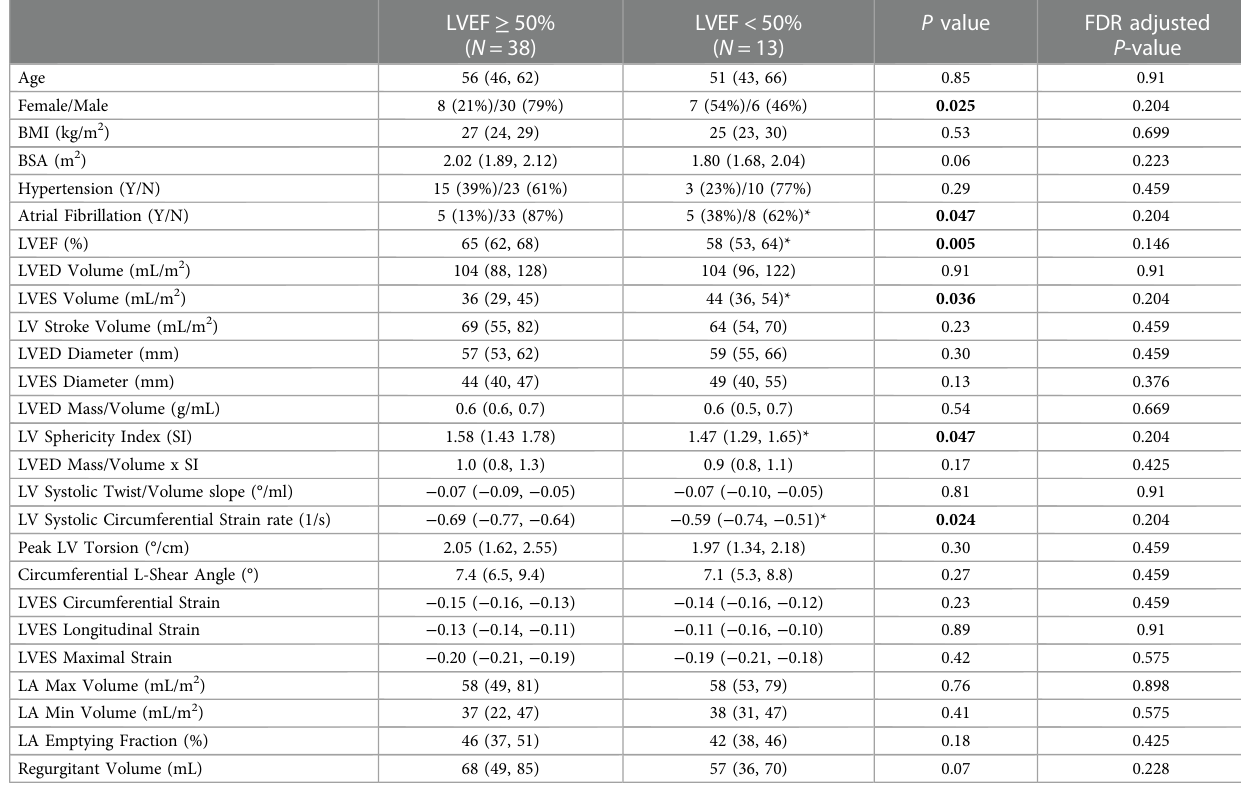
TABLE 2 Pre-Surgery baseline demographic and CMR data separated by LVEF ≥ or <50% at 6 months post-surgery ( N